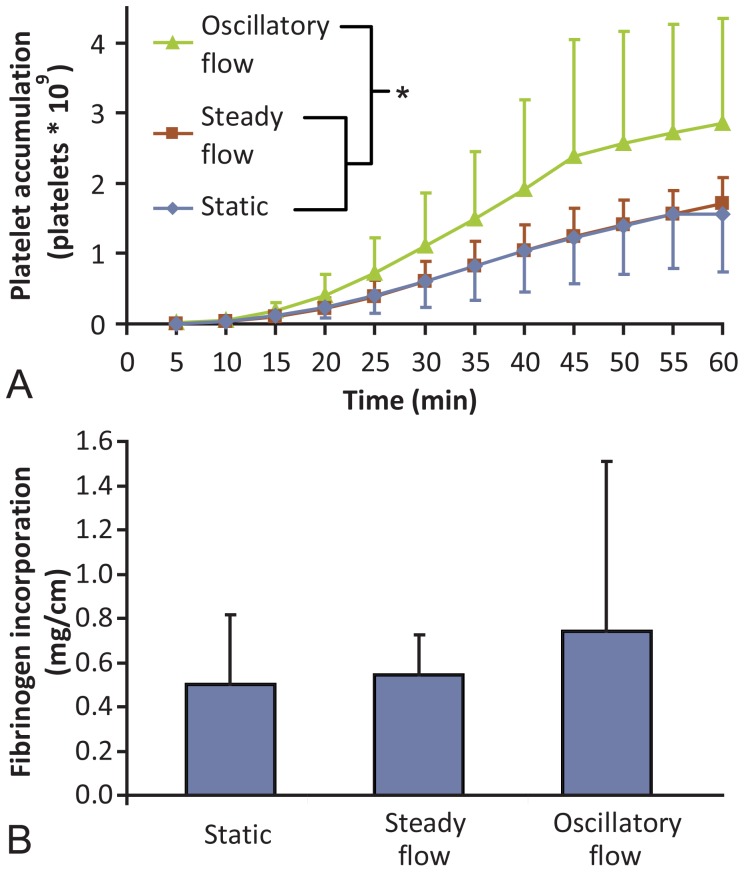

Ex vivo platelet and fibrin data.EOC-seeded grafts in the ex vivo shunt loop had significantly more platelet deposition over 60 min when pretreated with oscillatory shear stress compared to either steady shear stress or no flow preconditioning (A) (*p = 0.01). Fibrinogen incorporation (B) also trended higher in oscillatory treated samples, but was not statistically different (p = 0.13). In samples that occluded before 60 min, platelet count at the time of occlusion was included through 60 min for the purposes of illustration. This occurred in three of the oscillatory samples. ANOVA, N≥9.